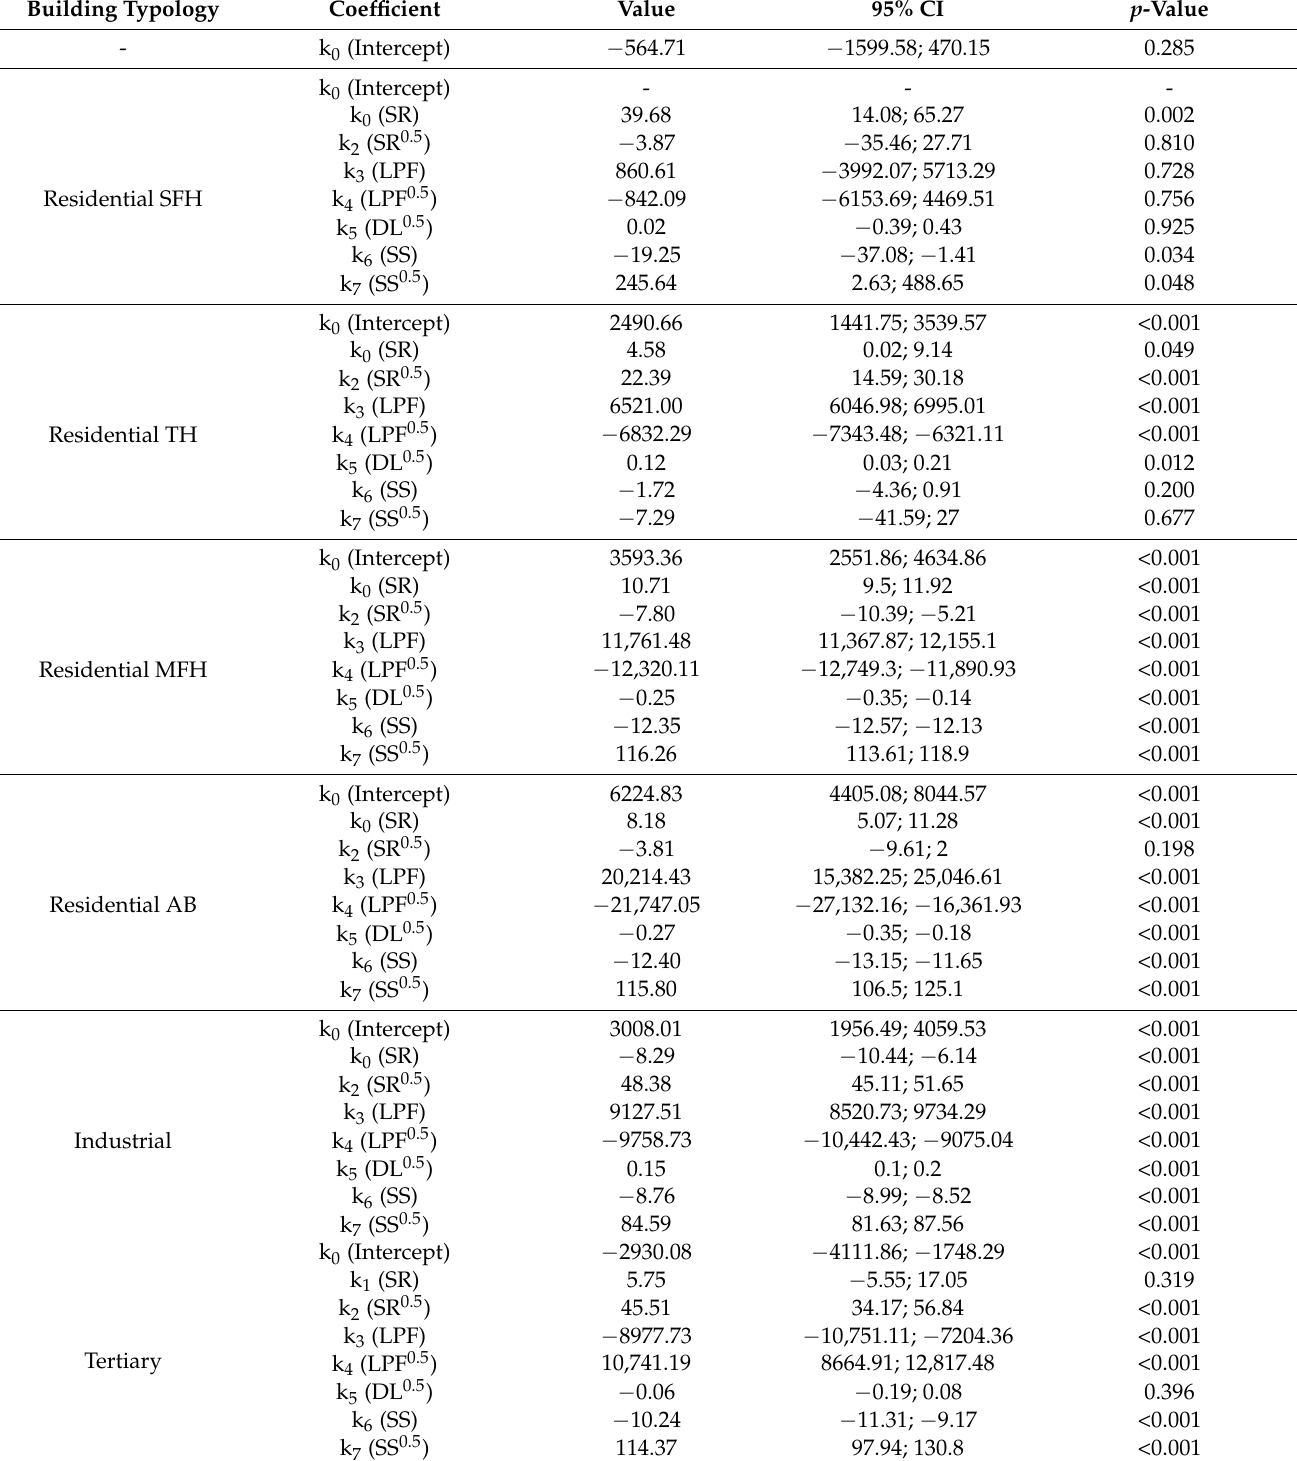
Table A2. QR coefficients to estimate SC for each building